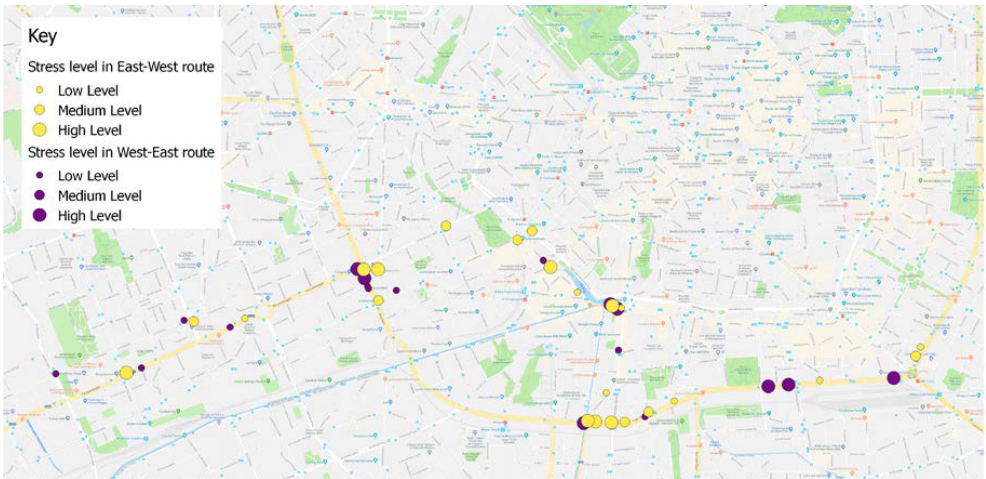
Figure 10. Location of the peak stress points (QGIS elaboration of Google Maps).